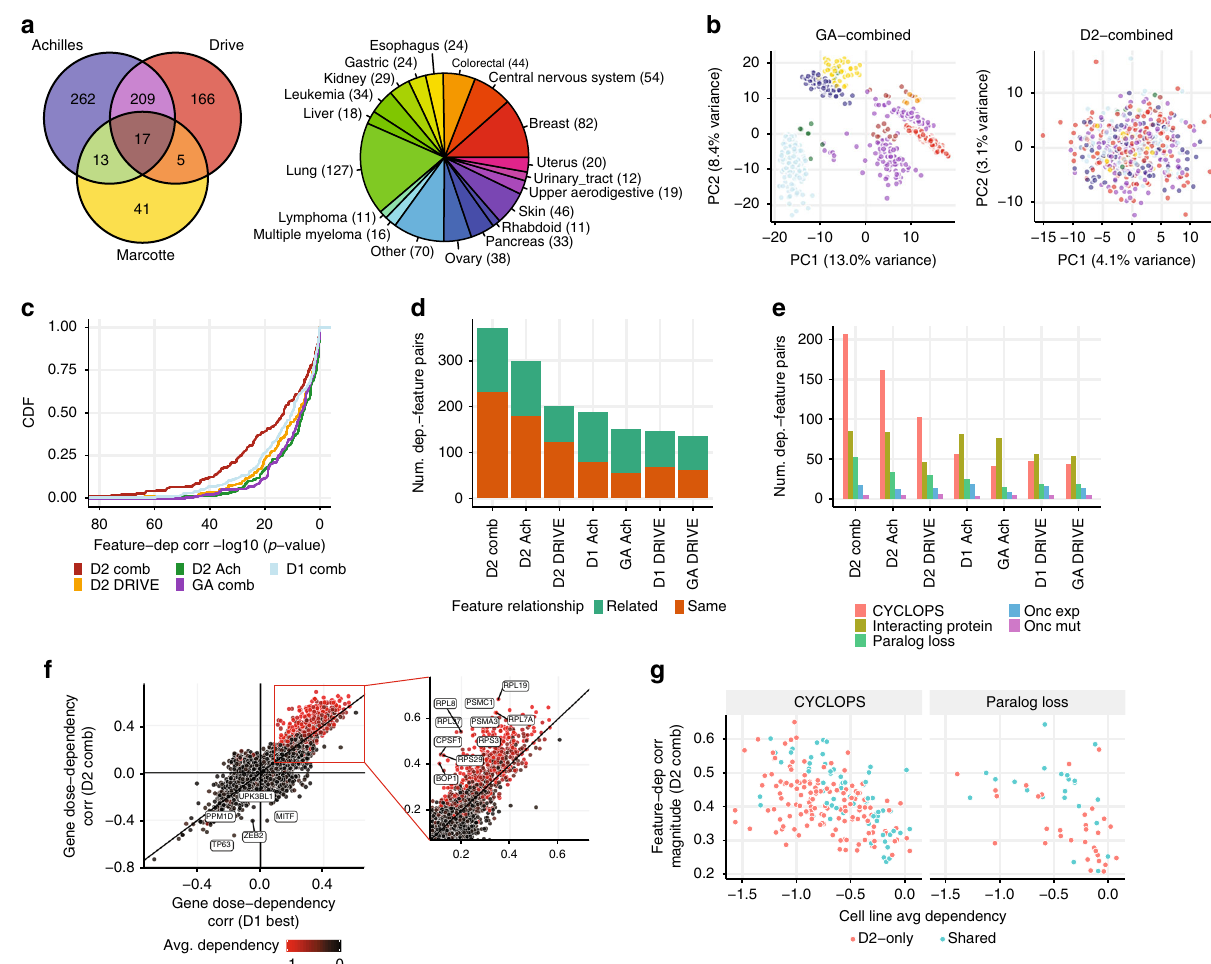
Fig. 5 D2 effectively integrates multiple RNAi screen datasets. a Venn diagram showing the overlap of cell lines screened across the DRIVE, Achilles and Marcotte et al. datasets. Pie chart showing the composition of the combined dataset by primary disease. b The fi rst two principal components of the gene dependency data for the combined GA (left) and D2 (right) data. Different colors represent which set of experiments were used to screen each cell line. Color scheme is the same as a , though light and dark blue indicate the cell lines screened with the “ 98k ” and “ 55k ” libraries in the Achilles dataset. c The statistical signi fi cance of measured associations between the benchmark dependency/feature pairs (same set as in Fig. 4e) is greatly increased when using the combined D2 dataset. Plot shows the empirical CDF of negative log p -values for dependency-feature associations using each model. d Number of gene ’ s whose dependency pro fi le is most correlated with a genomic feature that is from the same (red) or a related (green) gene, when using different models and datasets. e Dependency-feature associations identi fi ed by each model are classi fi ed as CYCLOPS, oncogene expression, oncogene mutation, paralog loss, and physical interactions. The D2 combined model identi fi es more relationships in nearly every class compared to using the individual datasets or other models. f Correlation between gene dependency and gene dosage (either mRNA or copy number) is compared across genes using either the combined D2 data or the best correlated of either D1 dataset (Achilles or DRIVE; see Methods). Subset at the right shows genes with strong positive dose-dependency correlations (i.e., CYCLOPS-like genes). g Comparison of feature-dependency correlation magnitude (in D2 combined data) with across- cell-line average dependency for CYCLOPS (left) and paralog loss (right) relationships. Color depicts which relationships were uniquely identi fi ed by the D2 combined data vs. shared with D1